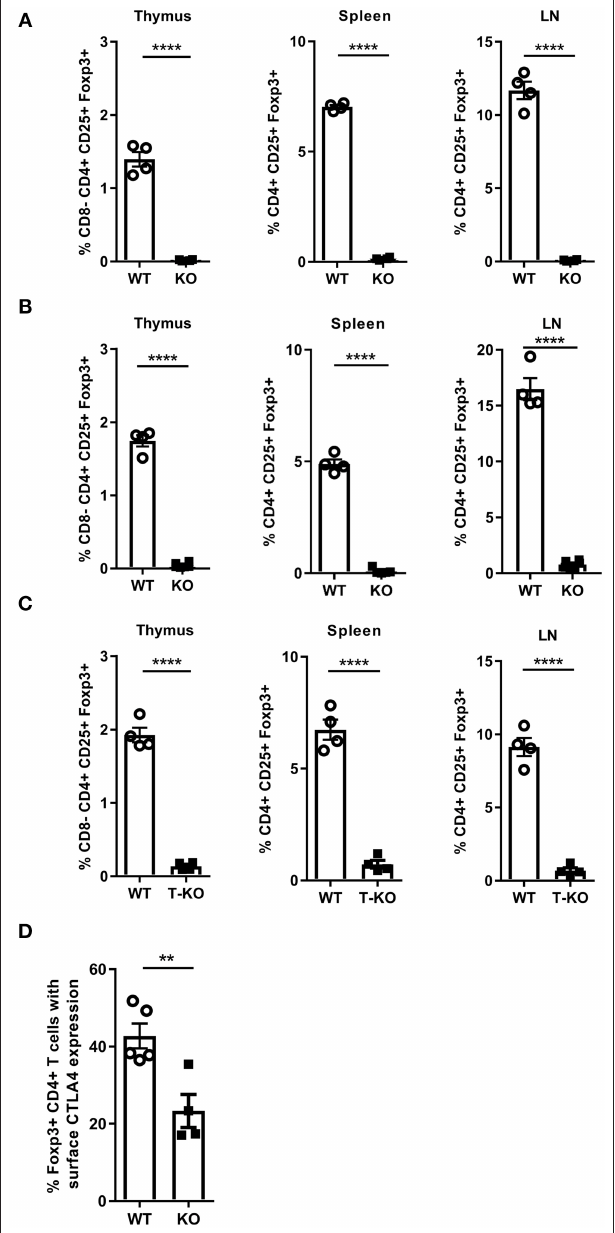
FIGURE 3 | MALT1 plays a T cell-intrinsic role in Treg development. (A) Percentage of Tregs (Foxp3 + CD25 + CD4 + T cells) in the thymus, spleen and lymph nodes of Malt1 -WT and Malt1 -KO mice without skin lesions (WT: n = 4 and KO: n = 4, age 10–12 weeks). (B) Percentage of Tregs (Foxp3 + CD25 + CD4 + T cells) in the thymus, spleen and lymph nodes of older WT and Malt1- KO mice with skin lesions (WT: n = 4 and KO: n = 6, age 6.5–8.5 months). (C) Percentage of Tregs (Foxp3 + CD25 + CD4 + T cells) in the thymus, spleen and lymph nodes of WT ( Malt1 FL / FL CD4-Cre + / + , n = 4), and T-KO (Malt1 FL / FL CD4-Cre Tg / + , n = 4) mice. (D) Percentage of splenic Tregs (Foxp3 + CD4 + T cells) expressing CTLA-4 on their surface after stimulation for 4h with PMA and IO in WT ( n = 5) and Malt1- KO ( n = 5) mice. The mean ± SEM is indicated on the graphs. The statistical significance between groups was calculated with an unpaired 2-tailed Student’s t -test: ** P < 0.01 and **** P <